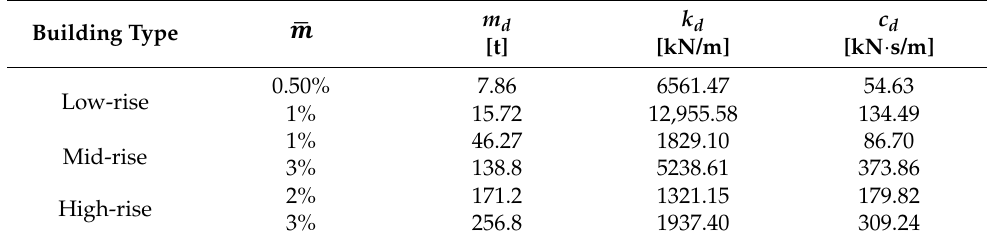
Table 4. TMD design parameter values for the three investigated buildings.